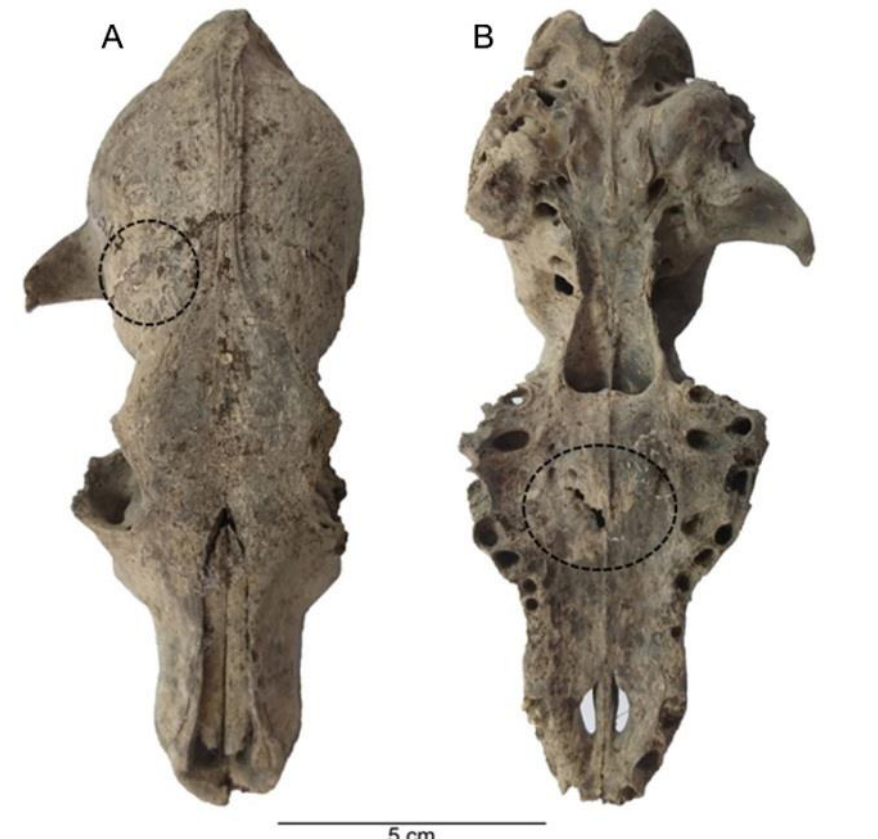
Figure 6. A dog skull from Alaybeyi Höyük showing frontal and palatal healing fractures: ( A ) frontal; ( B ) palatal.